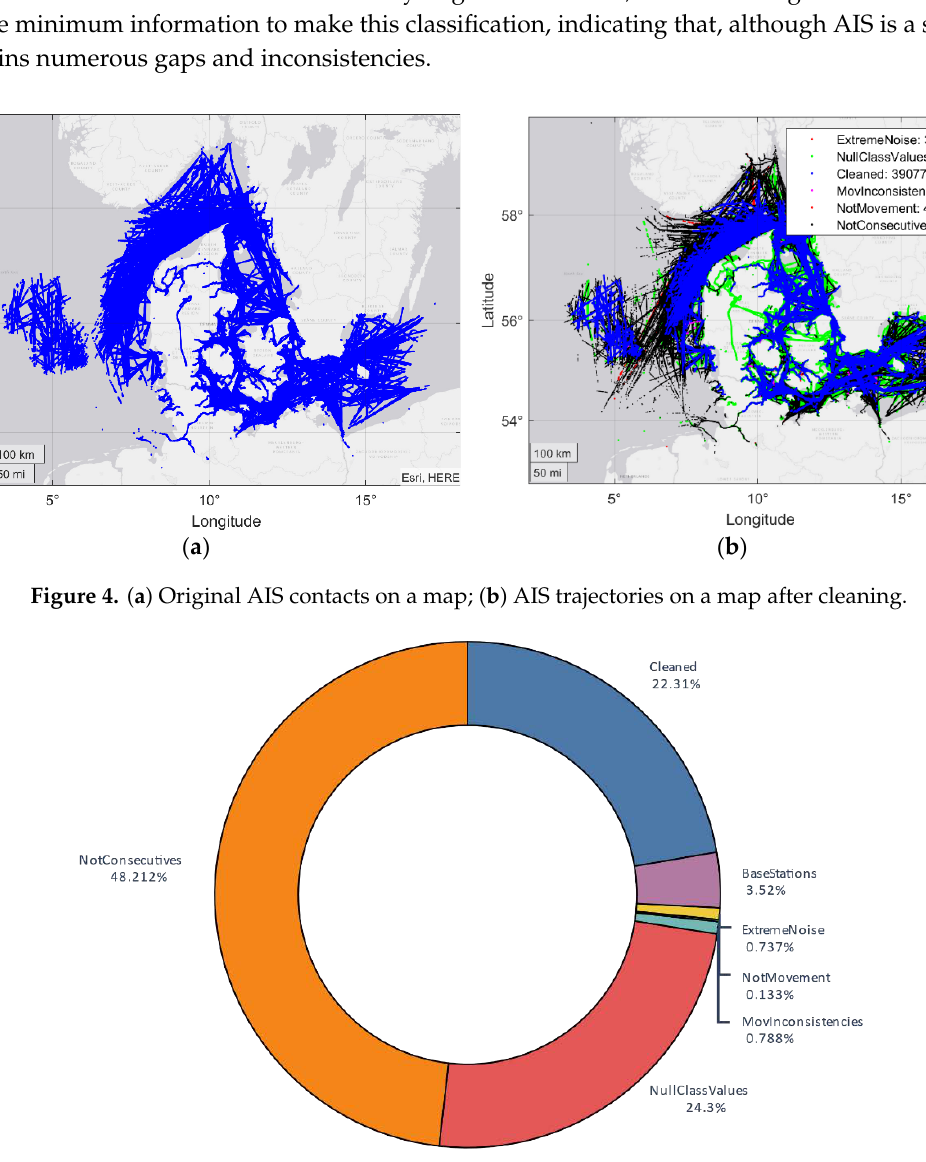
Figure 5. Distribution of contacts.